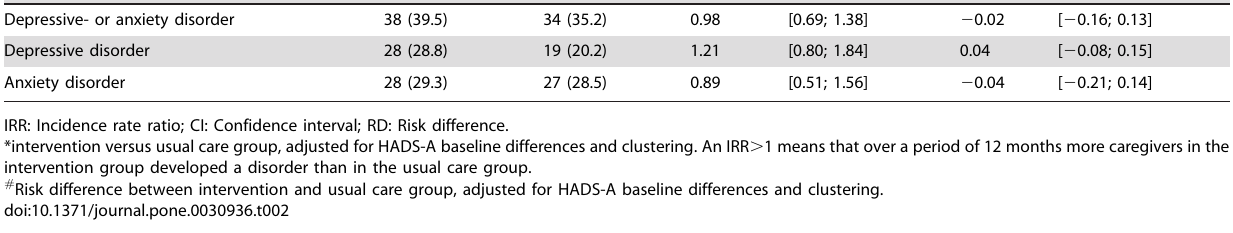
Primary endpoint Intervention